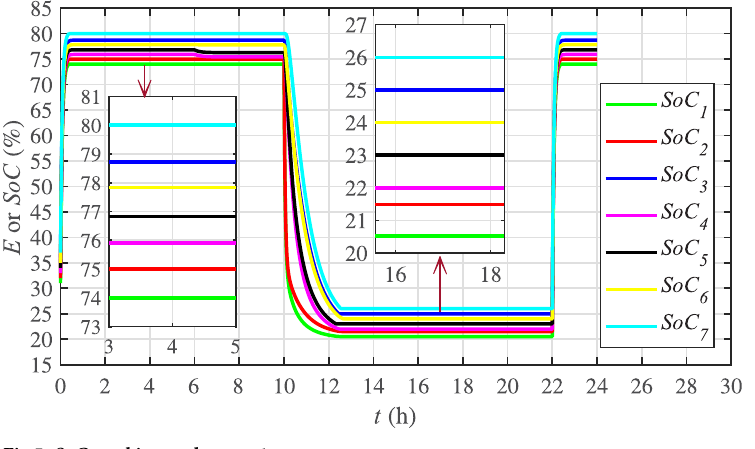
Fig 5. SoC tracking under case 1.